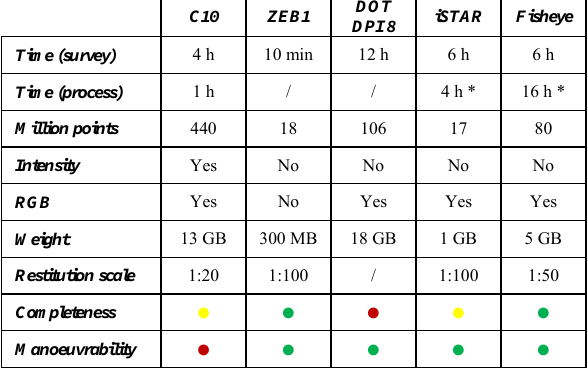
Table 1. Summary of the results per each